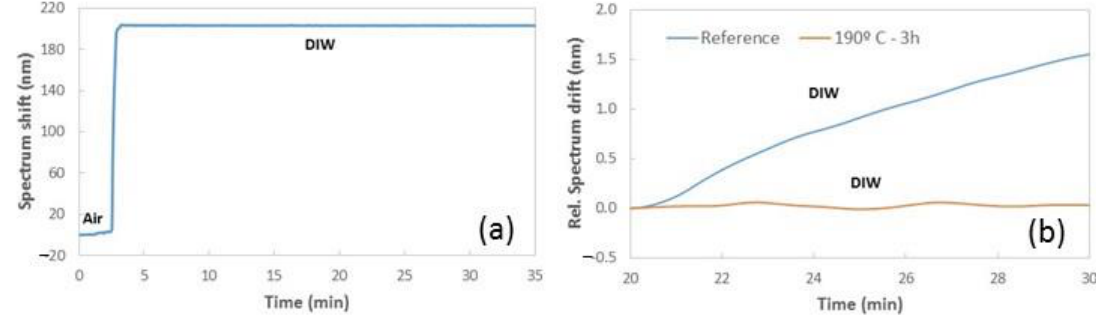
Figure 10. ( a ) Temporal evolution of the spectrum shift when flowing DIW in real-time for a PA6 NFs layer, after a heat treatment at 190 °C for three hours. ( b ) Comparison of the relative spectrum drift when flowing DIW, between minutes 20 and 30, for the reference sample and the one heated at 190 °C for three hours.